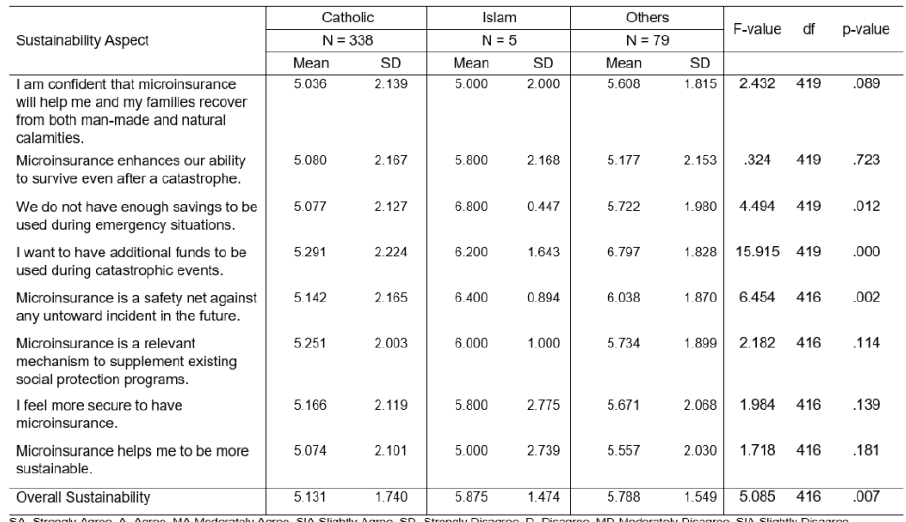
Table 5: Level of Agreement of the Respondents on the Sustainability aspect of Microinsurance When Grouped According to Religion